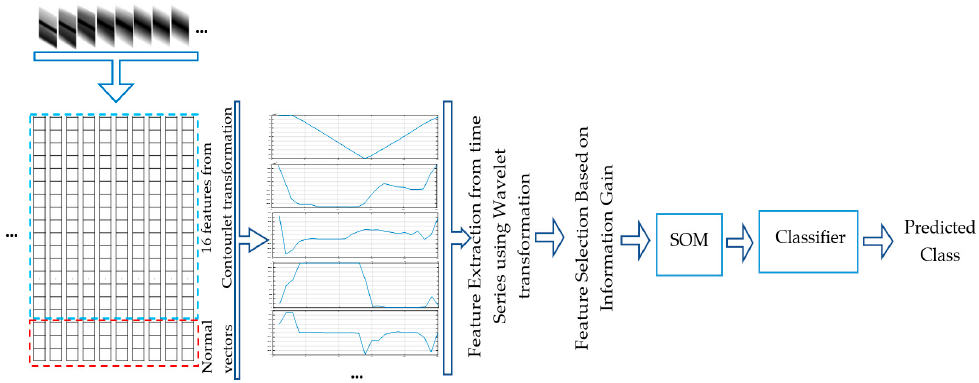
Figure 8. Process of object classification using conventional classifiers.